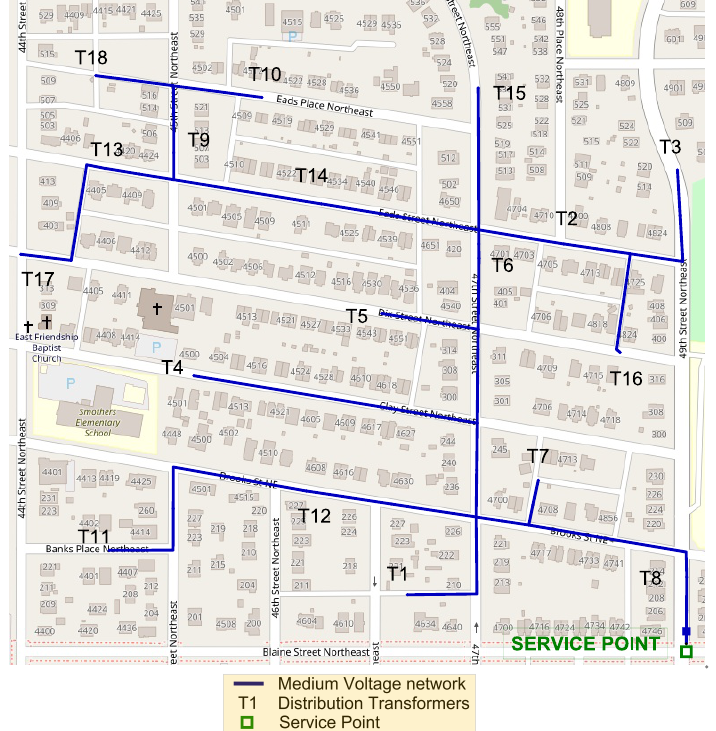
Figure 7. Routing of primary feeder using MST techniques for case study 2 performed on PowerFactory